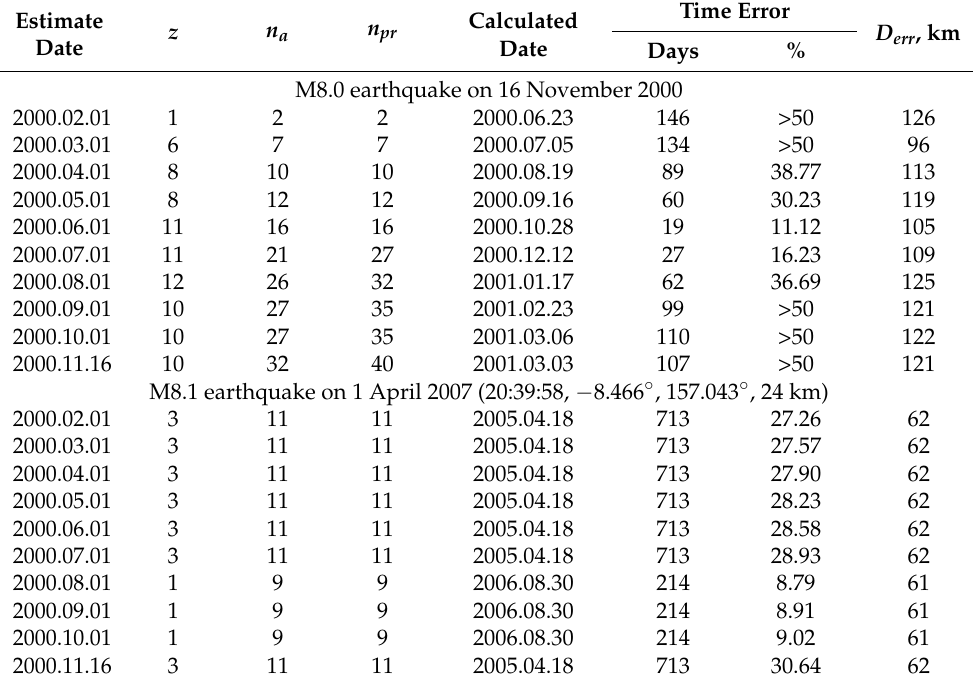
Figure A4. Retro predictability of the earthquake on 16 November 2000 in the zone with the highest (at the estimate date, see Figure A3, column ‘a’) number of successful predictive extrapolations. 1—factual data, 2—approximations, 3—the moment of retro-prediction, 4—extrapolations, 5—the earthquake of 16 November 2000 in factual data and 6—calculation position for the earthquake of 16 November 2000. Table A5. Retro estimation of the place and time of earthquakes by clusters of the precedent activity for earthquake 16 November 2000.